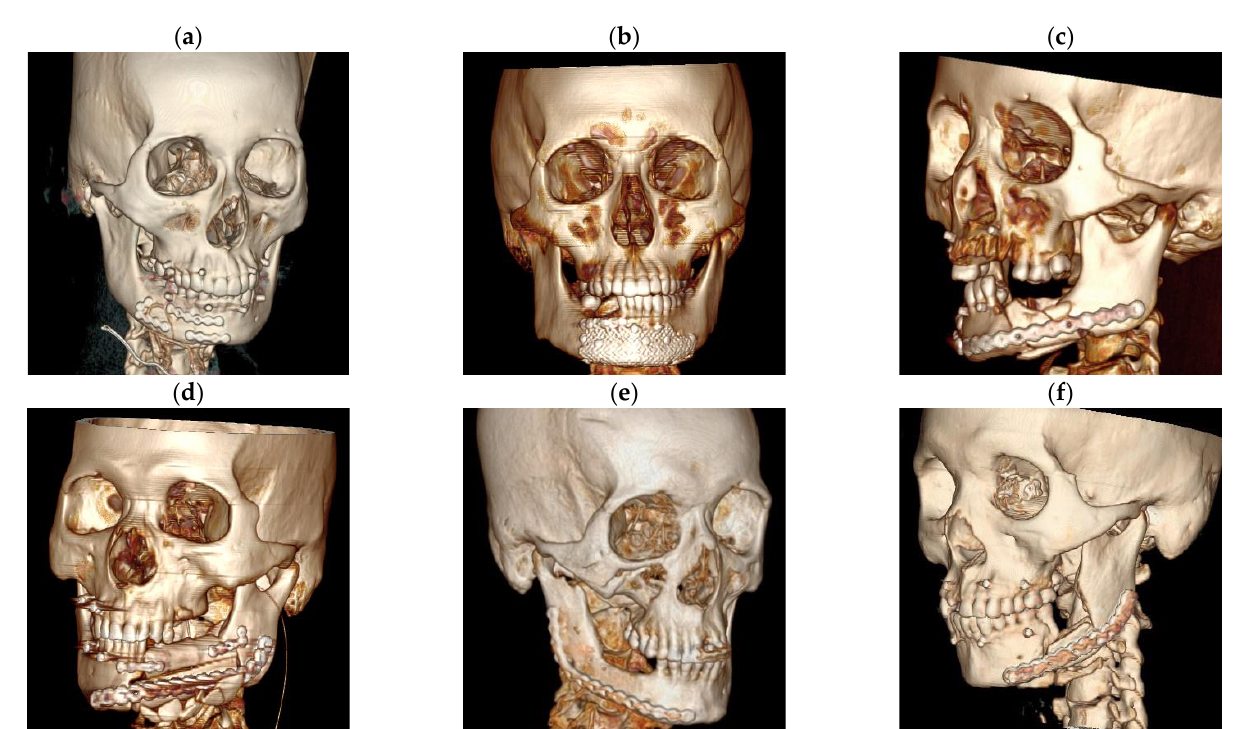
Figure 2. Postoperative 3DCT reconstruction of each fracture category. ( a ) Type II fracture managed with miniplates fixation following the Champy’s principle; ( b ) type III fracture, MMF, staged surgeries and titanium mesh fixation were performed; ( c ) type IV fracture managed with reconstruction plate systems fixation following the AO/ASIF principles; ( d ) reconstructed with fibular microvascular osteocutaneous free flap; ( e ) reconstructed with scapular microvascular osteocutaneous free flap; ( f ) reconstructed with iliac microvascular osteocutaneous free flap. 3DCT: three-dimensional computed tomography; MMF: maxillomandibular fixation; AO/ASIF: Arbeitsgemeinschaft fuer Osteosynthesefragen/Association for the Study of Internal Fixation.